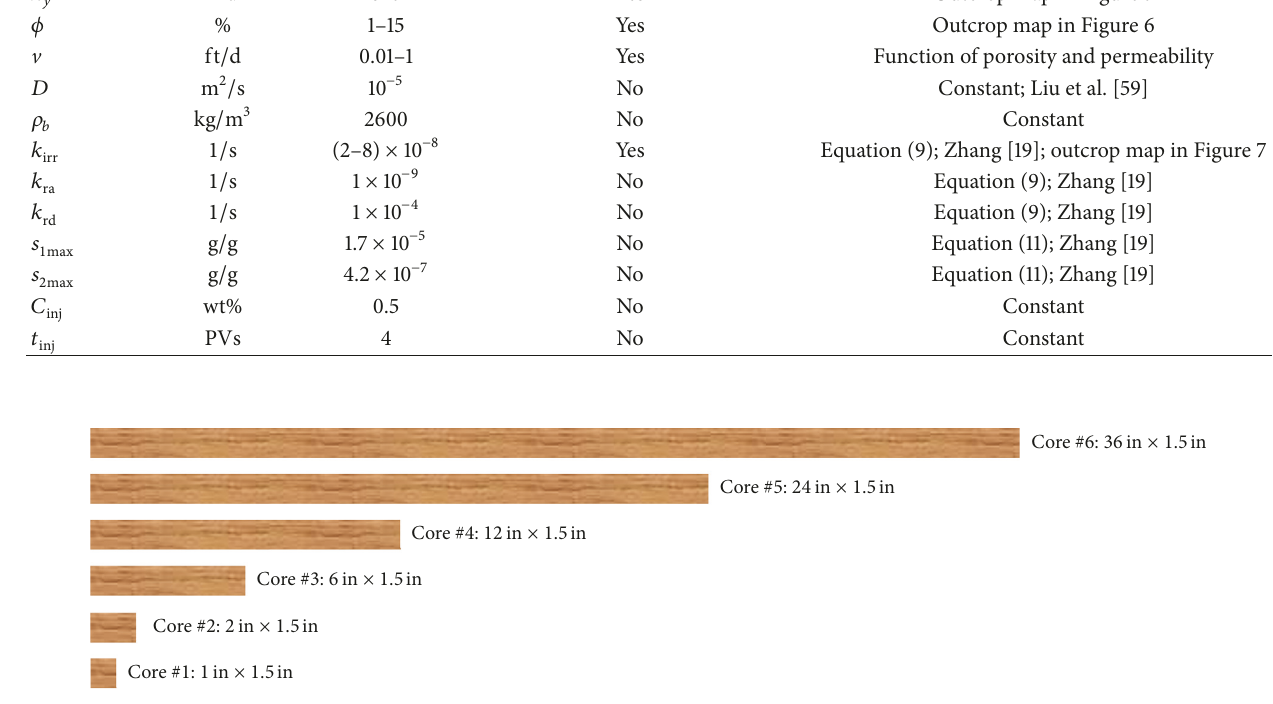
Figure 2: Six cores with increasing length at laboratory scale.